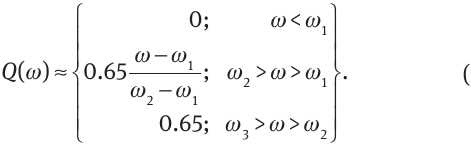
sufficiently small values of length L and radius R quali- c 0 tatively recover the experimental data shown in Figure 3A, notably the exponential decay of the photon counts with the number of channels opened. We use the model described above to match the experimental dependence of the photon counts versus electrical power delivered in the contact displayed in Figure 3B, again consider- ing the two extreme heat exchange scenarios at the side wall. The open blue and magenta triangles in Figure 3B are the results of the models considering a short cylinder = λ = 2 λ of length L /4 and R . We estimate the total radia- c F 0 F tion area as detection efficiency is experimentally unknown, and we